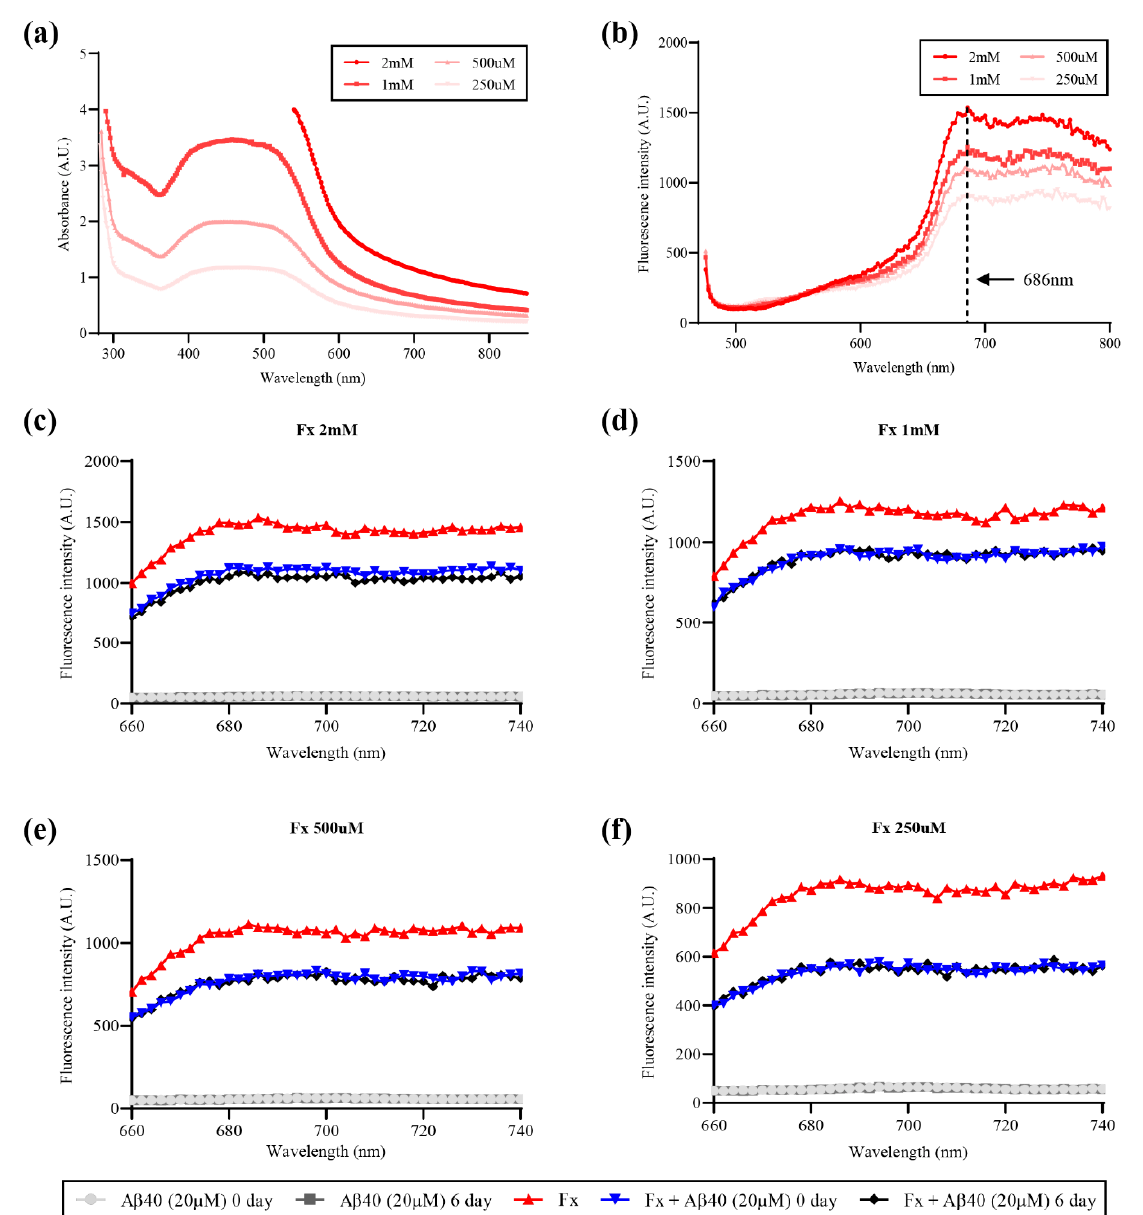
Figure 2. The fluorescent properties of fucoxanthin. Excitation and emission wavelengths of fucoxanthin at various concentrations were determined through absorbance ( a ) and emission scan ( b ); excitation, 444 nm; emission, 686 nm. Fluorescent spectra of each fucoxanthin solution with A β 40 monomers or aggregates in a 3:1 ratio were recorded with excitation and emission wavelengths as above ( c – f ). A.U. = arbitrary unit.